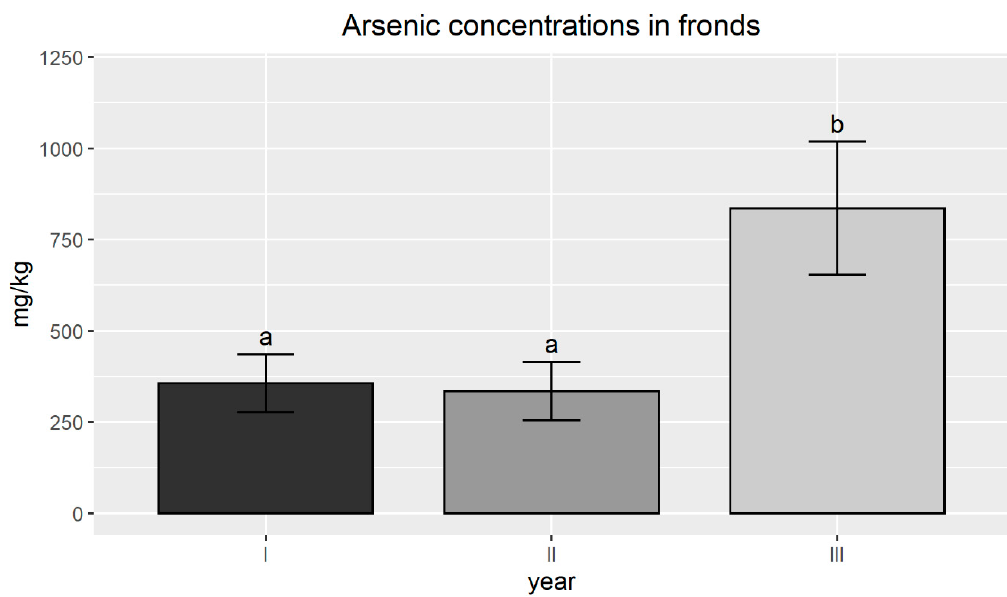
Figure 5. Arsenic average concentration (mg/kg) measured in P. vittata frond samples collected from the six subareas (SBs). Error bars indicate standard error and different letters indicates that the differences among the years were significant ( p -value < 0.05).